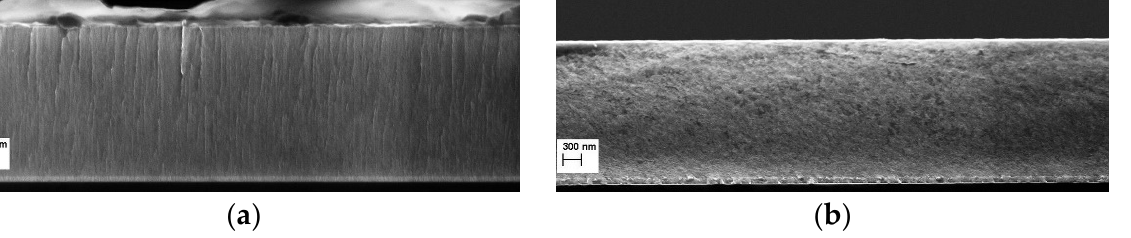
Figure 3. Fracture cross-sectional micrographs of ( a ) TaN2 and ( b ) TaAlN2 films, deposited using a bias voltage equal to −75 V.